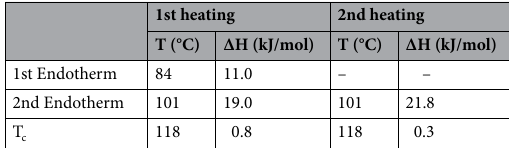
1st heating 2nd